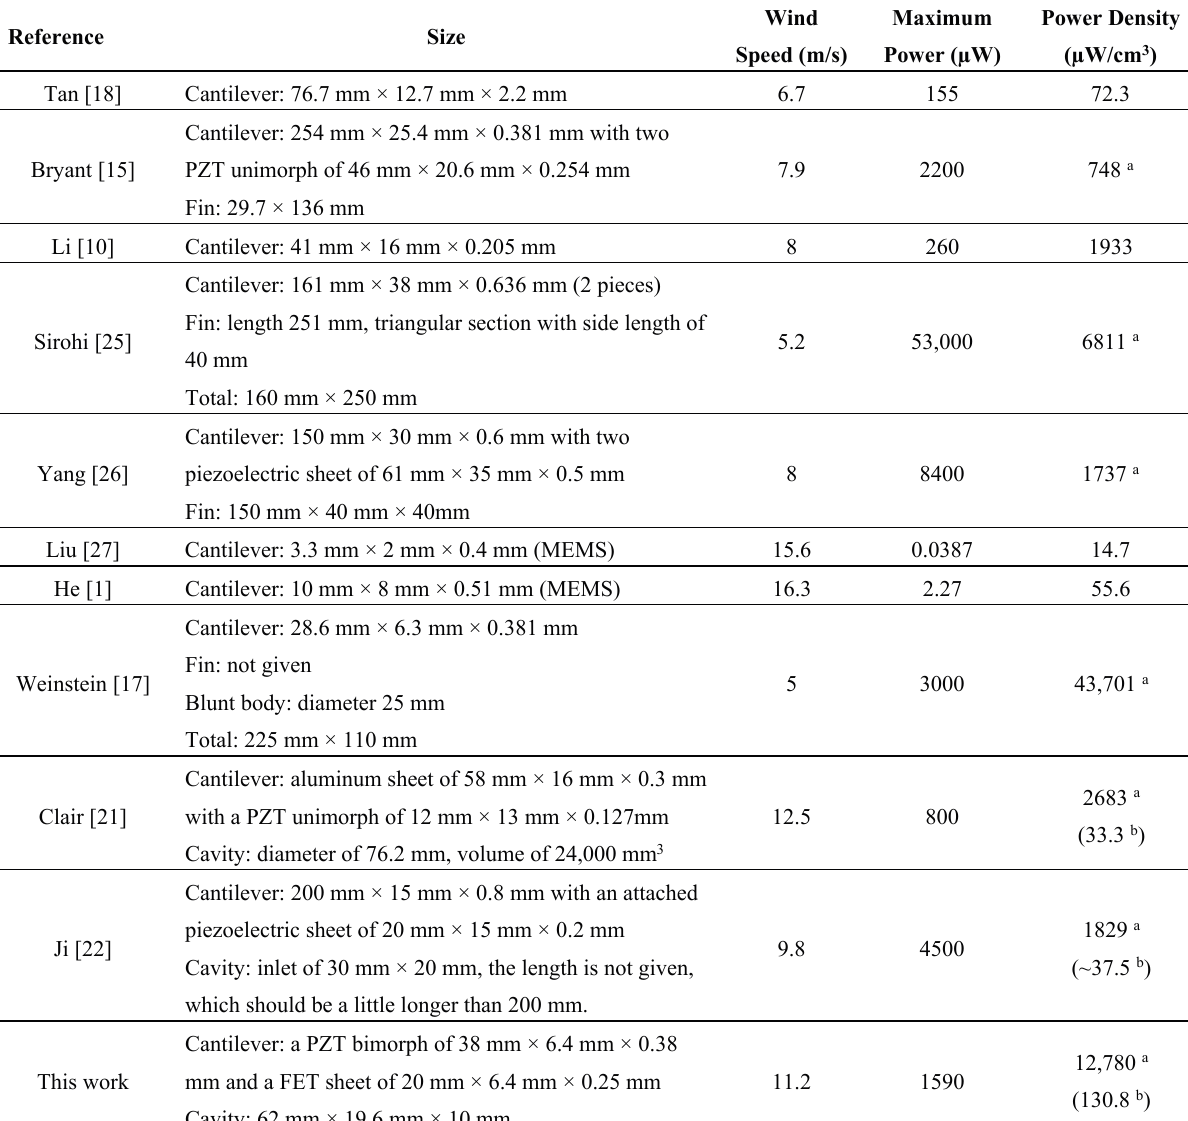
Table 1. Summary of several piezoelectric wind energy